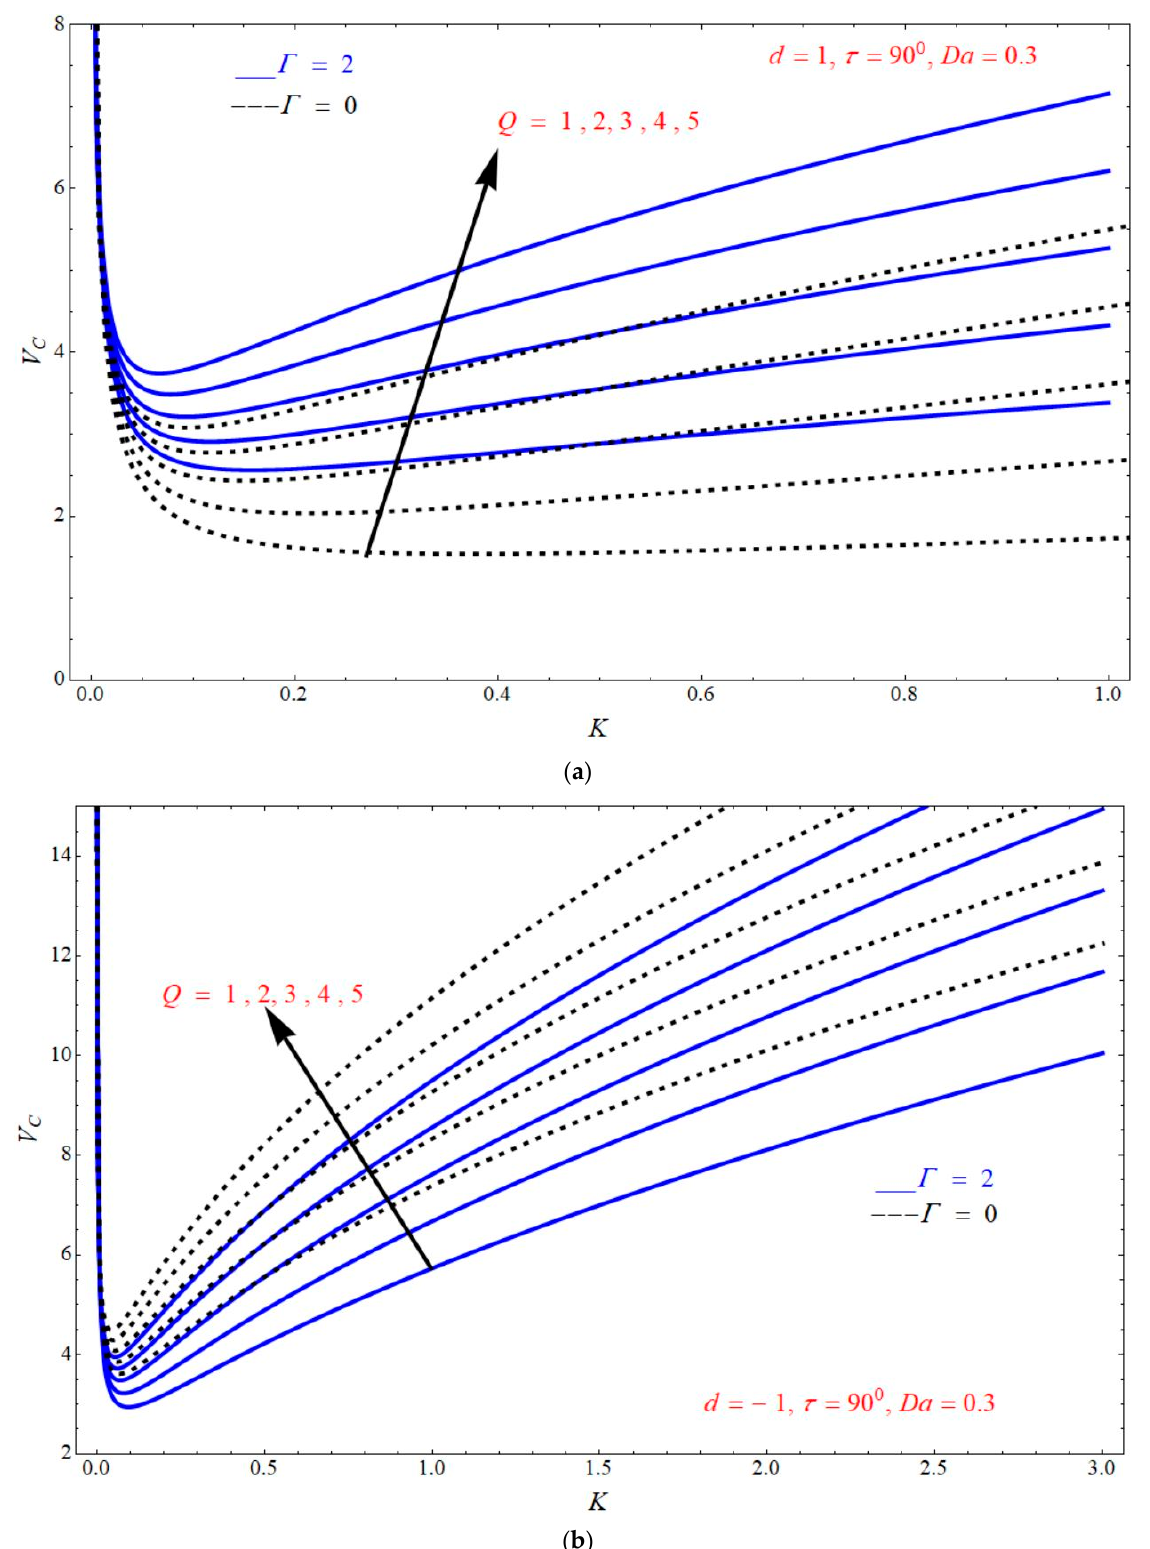
= . Figure 5. Impact of V C on K for different values of Q for both ( a ) d = 1 and ( b ) d =